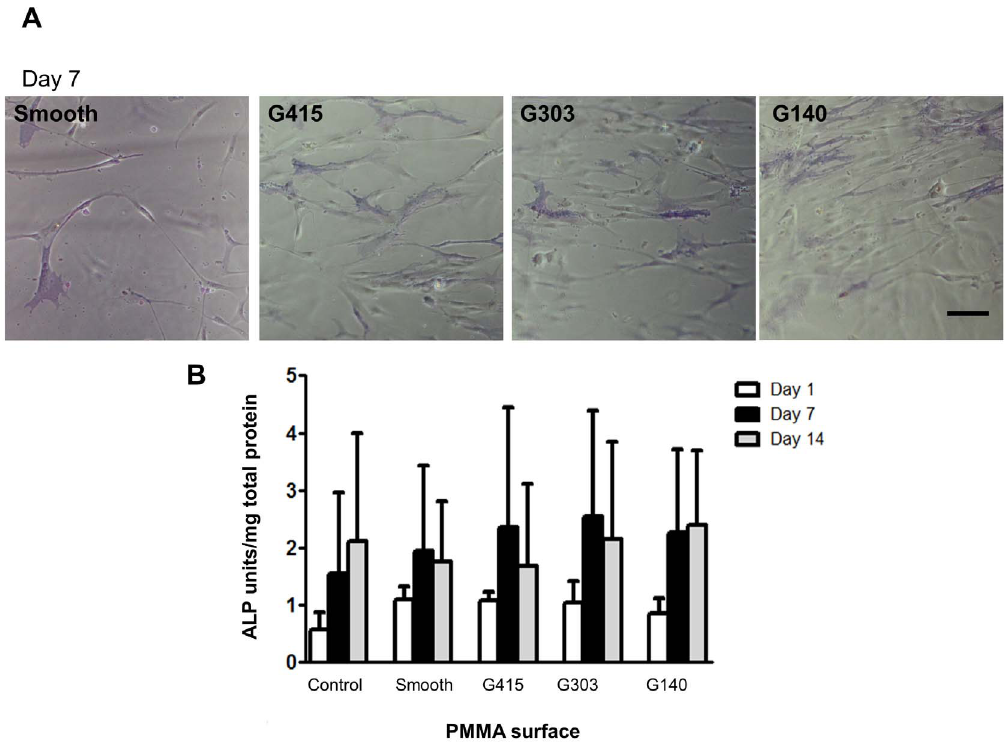
Figure 6. Alkaline phosphatase activities were not altered by culturing MSCs on nanotopography. (A) Micrographs of MSCs stained for active ALP after 7 days in osteogenic media (OBM) revealed no qualitative differences on PMMA nanotopgraphy. Scale bar represents 100 m m. (B) Quantification also revealed no significant differences in ALP activity for MSCs grown on nanotopography versus smooth PMMA substrates. The control group represents MSCs grown on smooth PMMA in osteogenic growth media (OGM).Data represent mean + / 2 standard deviation (n=3 for day 1 and n=5 for day 7, 14).